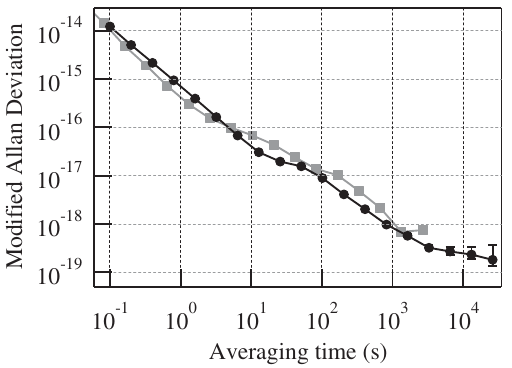
FIG. 5. Modified Allan deviation for the corresponding fre- quency transfer from site A to site B (black trace). The fractional frequency uncertainty reaches 2 × 10 − 19 . Up to 10 3 s, the uncertainty in the syntonized frequencies matches the fre- quency-comparison measurement of Ref. [36] over 2 km (gray trace) despite the additional complexity.